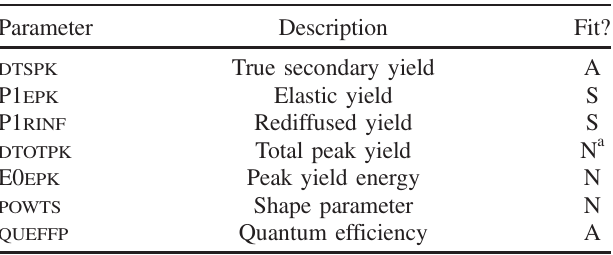
TABLE VI. List of beam conditions used for one round of fitting (15W Al chamber, May 2010), and which parameter they most strongly